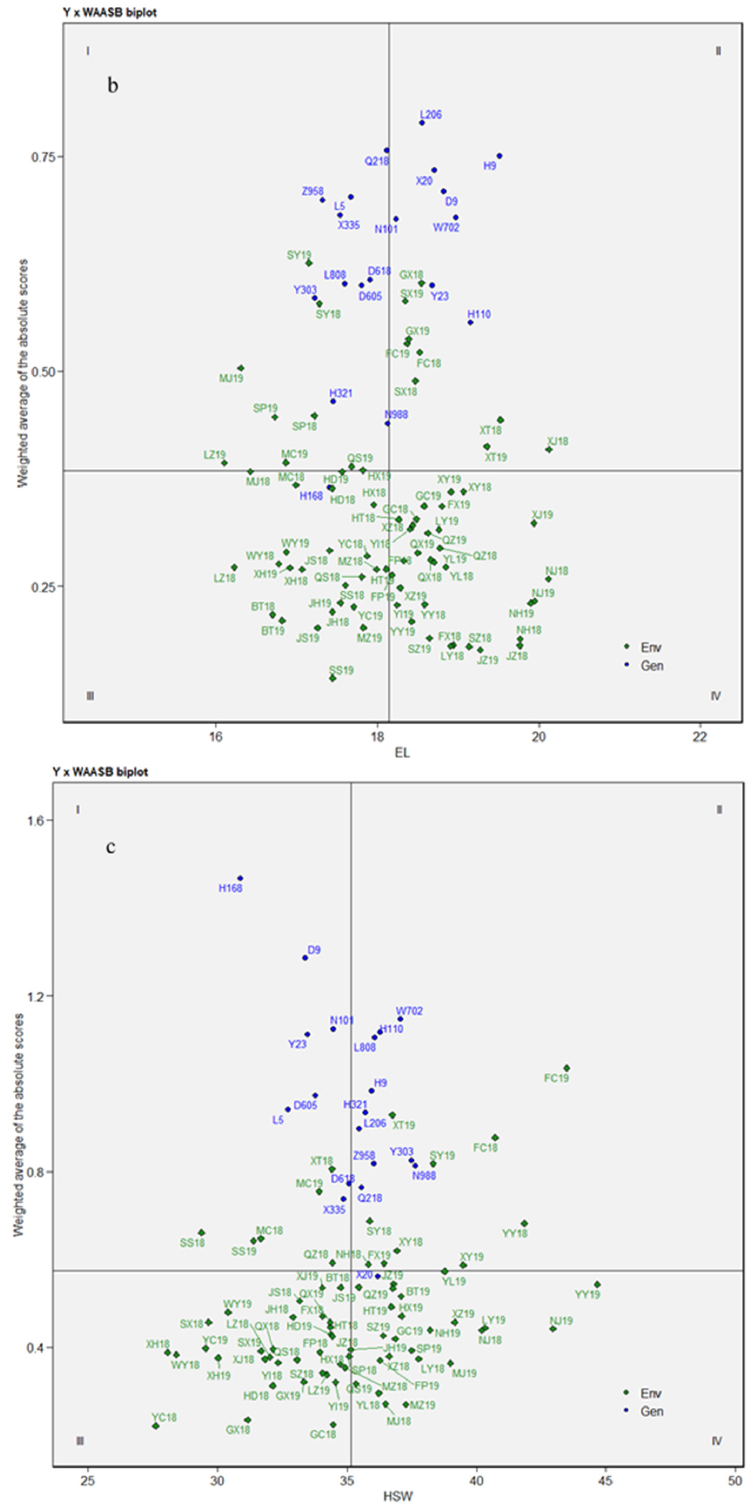
Figure 2. The biplot of agronomic traits combined with weighted average of absolute scores for the best linear unbiased predictions of the genotype vs. environment interaction (WAASB). GY, grain yield; EL, ear length; HSW, hundred seed weight. The blue and green icons represent the codes of environment and genotype, respectively. ( a ) represent grain yield (GY); ( b ) represent ear length (EL); ( c ) represent hundred seed weight